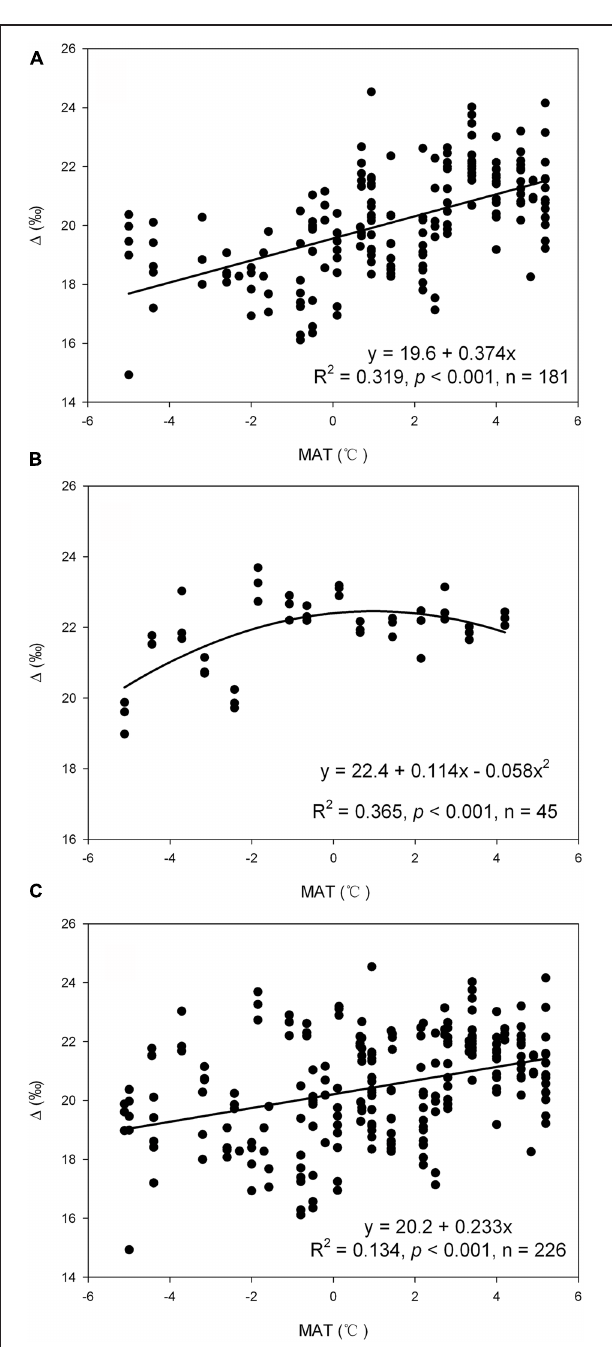
FIGURE 2 | The influence of mean annual temperature (MAT) on (cid:2) as suggested by regression analysis with data in Mount Gongga (A), Mount Segrila (B), and the whole dataset